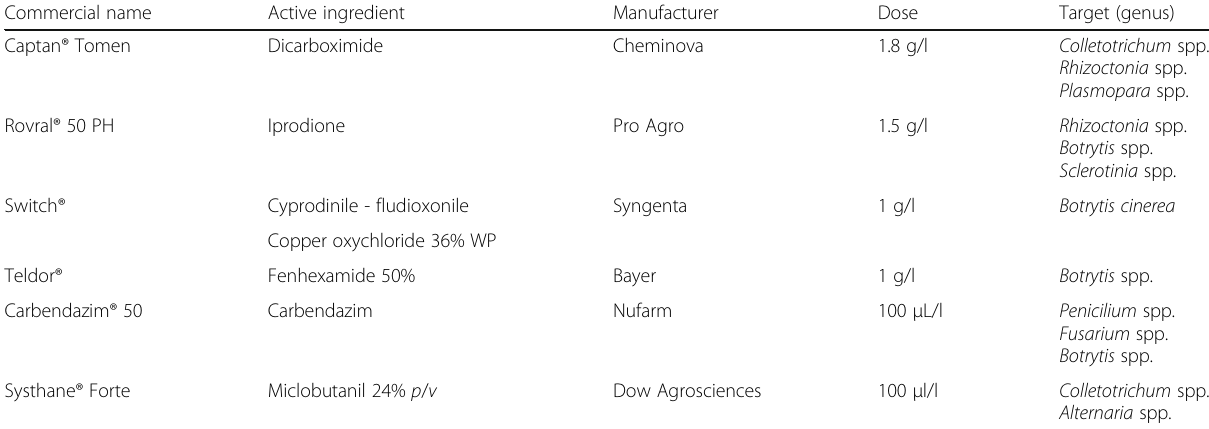
Table 2 Commercial fungicides used in trials (active ingredient and applied dose)